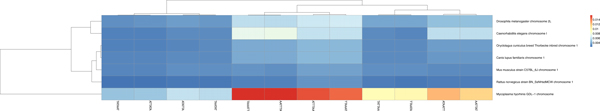
The AAATTT-spectrum set. This tree also resembles the taxonomy tree but there is a slight distance between mouse and rat which is not found in Figure 15. We note tree distinct subtrees conforming to the taxonomy tree.